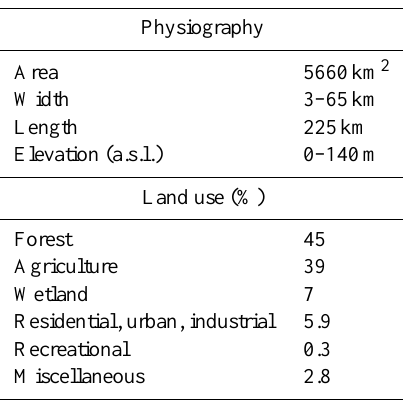
Table 1. Main physiographic and land use characteristics of Prince Edward Island (land use based on a LANDSAT image for